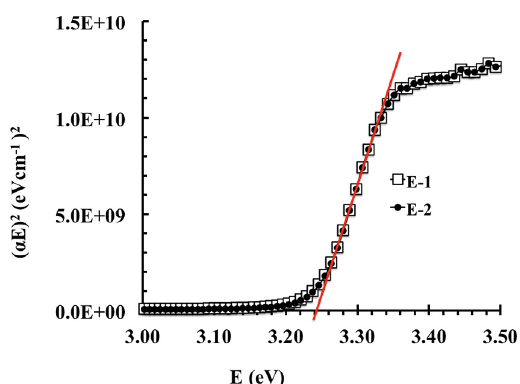
Figure 5. Tauc’s plot obtained through the application of K-M case for an infinitely thick layer. The two mathematical expressions applied for estimation of S (E-1 and E-2) resulted in analogous plotted profiles.